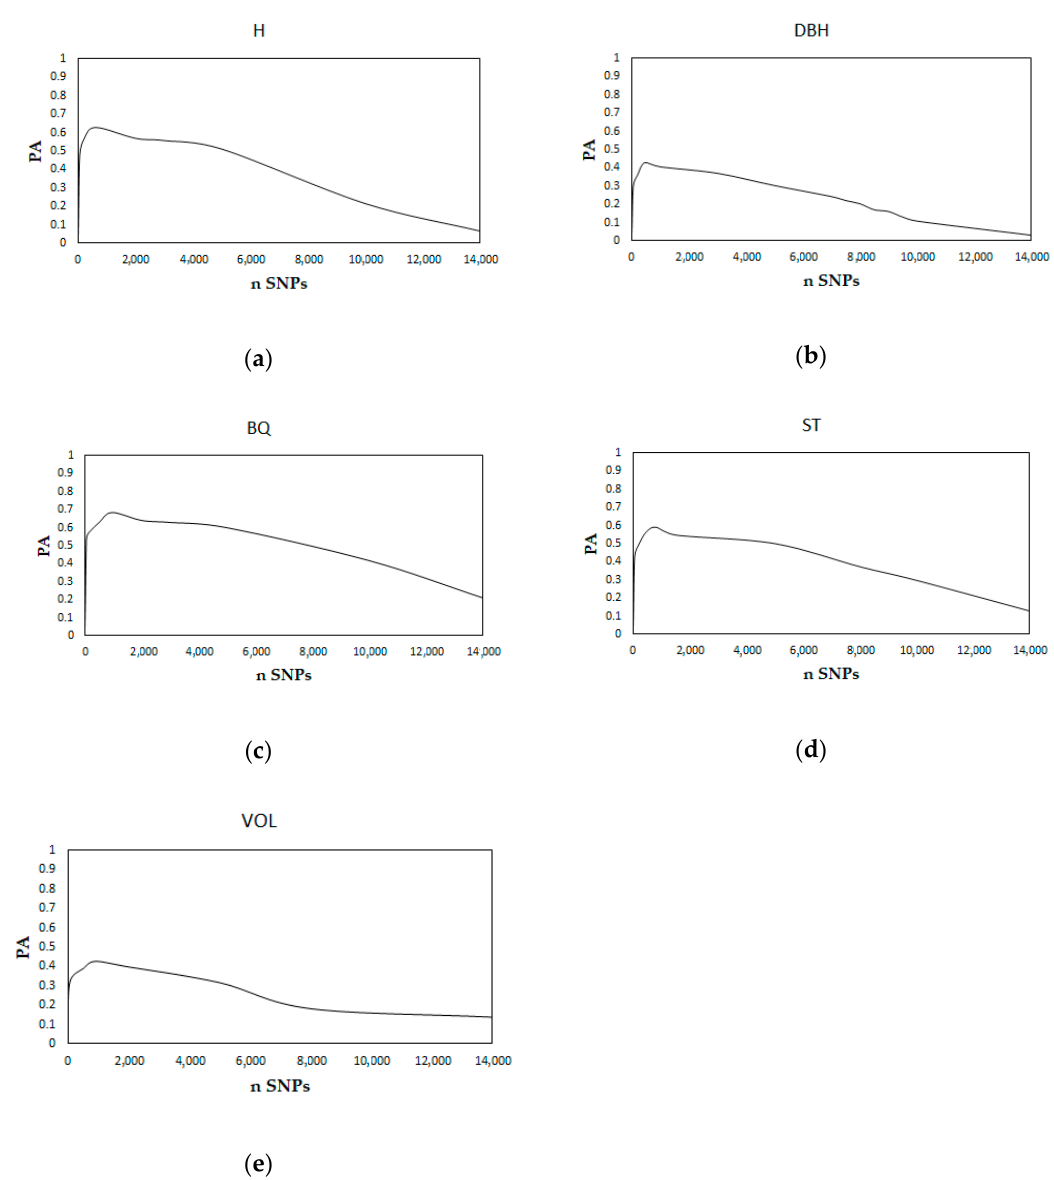
Figure 4. Predictive ability (PA) of the RRBLUP-B method (without cross-validation), where n SNPs corresponds to a subset of markers for ( a ) tree height (H), ( b ) diameter at breast height (DBH), ( c ) branching quality (BQ), ( d ) stem straightness (ST) and ( e ) stem volume (VOL).